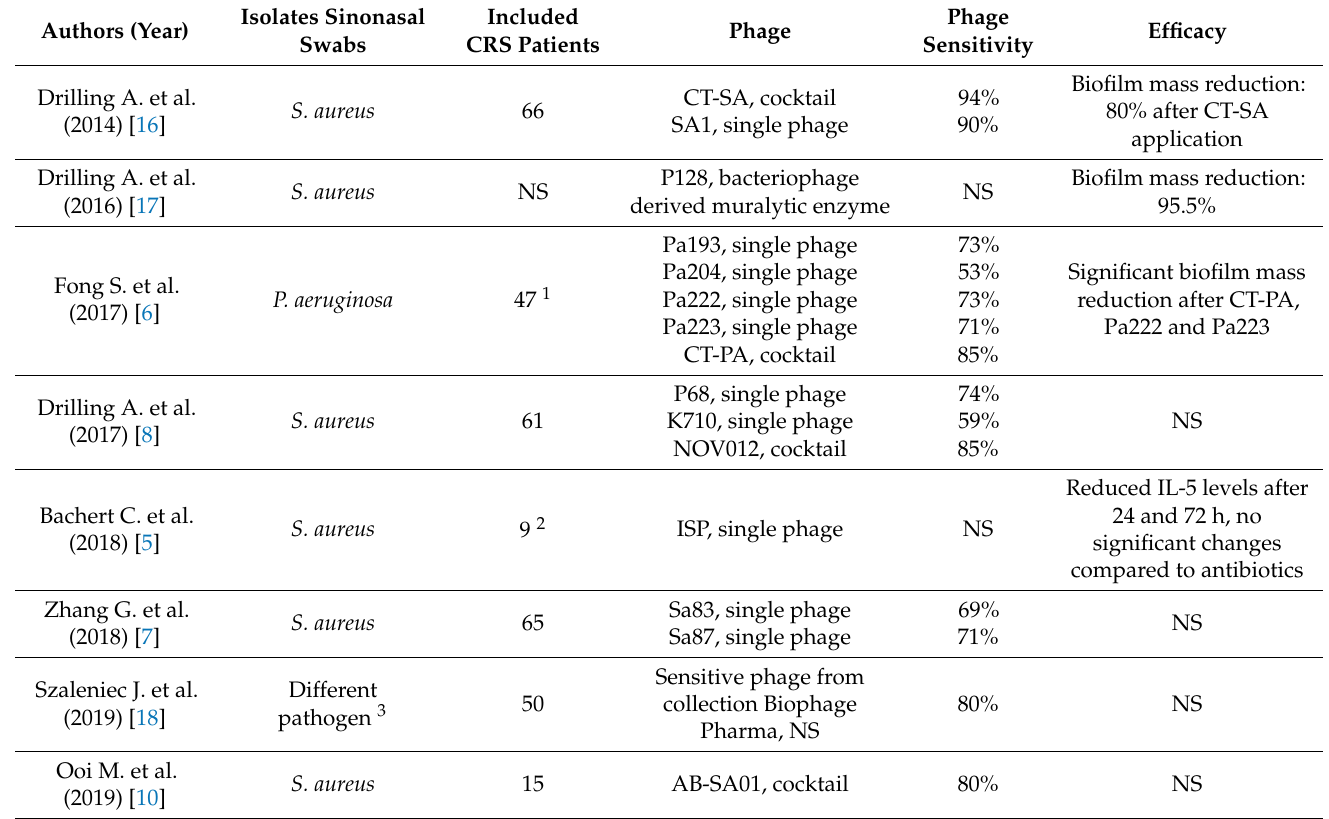
Table 2. Overview of in vitro studies demonstrating the sensitivity and efficacy of phages or phage-derived enzymes to ex vivo isolates from CRS